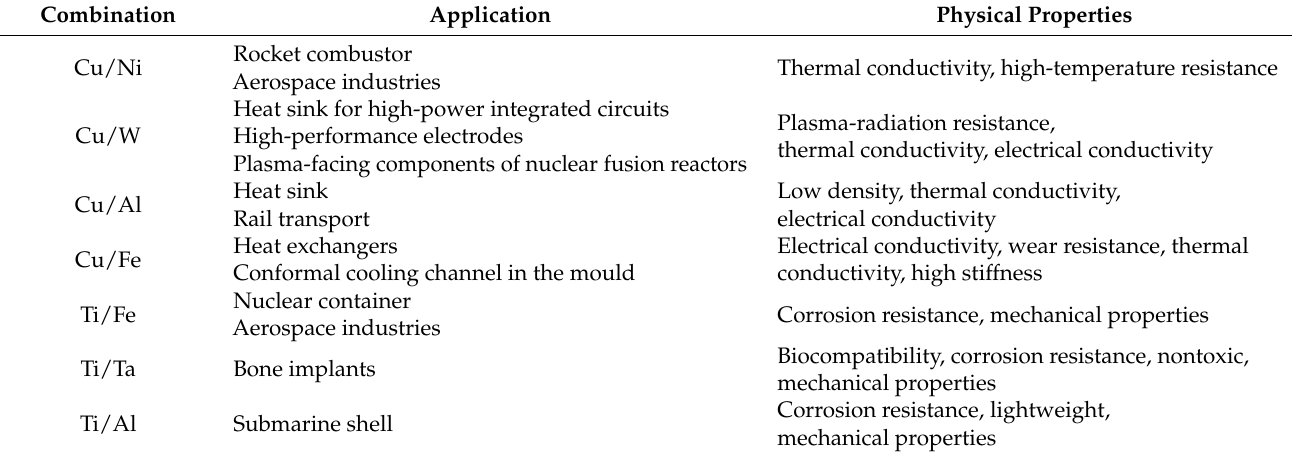
Table 2. Further potential applications of LPBF-processed dissimilar metal